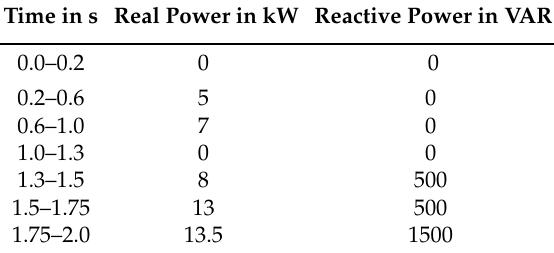
Table 2. AC load connection details.